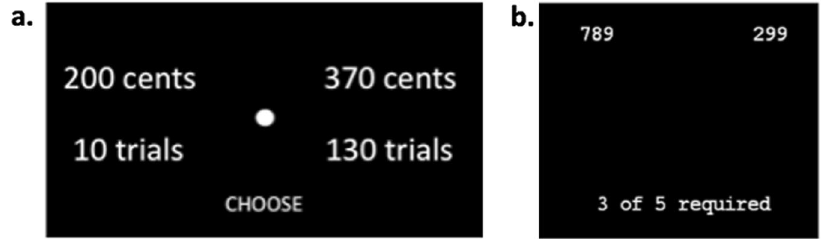
Fig. 1 Example trial from fMRI EDT Task. Participants selected between a low effort/low money (EASY) trial and a parametrically varied higher-effort/higher-reward (HARD) option ( a ). The effort “ trials ” participants were asked to consider were repetitions of a “ Bigger Number Task ” (BNT) utilized in previous motivation tasks and here performed out of scanner ( b